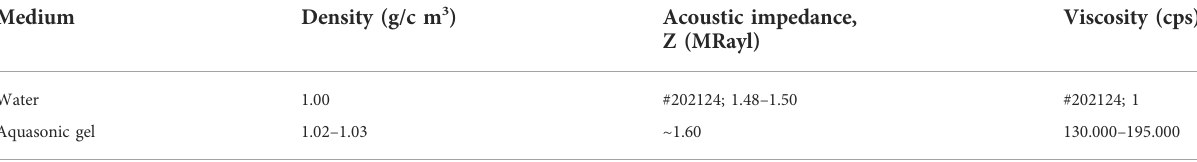
TABLE 1 Properties of water and coupling aquasonic gel at room temperature of 20 ° C.